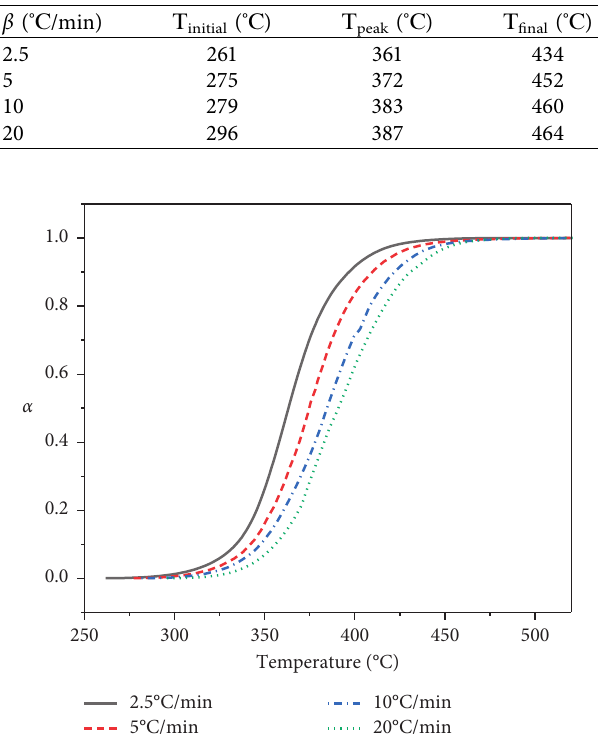
Figure 2: Dependence of the conversion degree ( α ) of the p-EGF: AA copolymer on temperature at different heating rates (2.5, 5, 10, and 20 ° S /min).